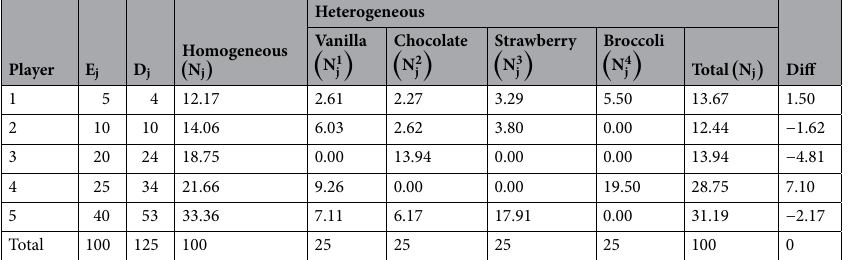
Table 2. Heterogeneous cake-cutting using the weighted Boltzmann division. E j = Contribution to cake production of player j D j = Need for cake of player j N i j = Cake share of flavor i allocated to player j Diff (Difference) = Heterogeneous (cid:31) N j (cid:30) —Homogeneous (cid:31) N j (cid:30)